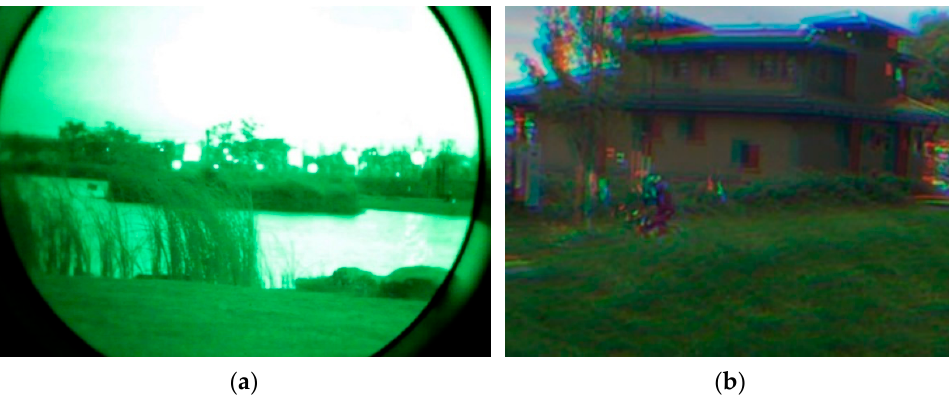
Figure 1. Imaging from image intensifiers and color-channel motion artifacts introduced by time- division color imaging: ( a ) typical monochromatic image from an image intensifier; ( b ) color-channel motion artifacts.